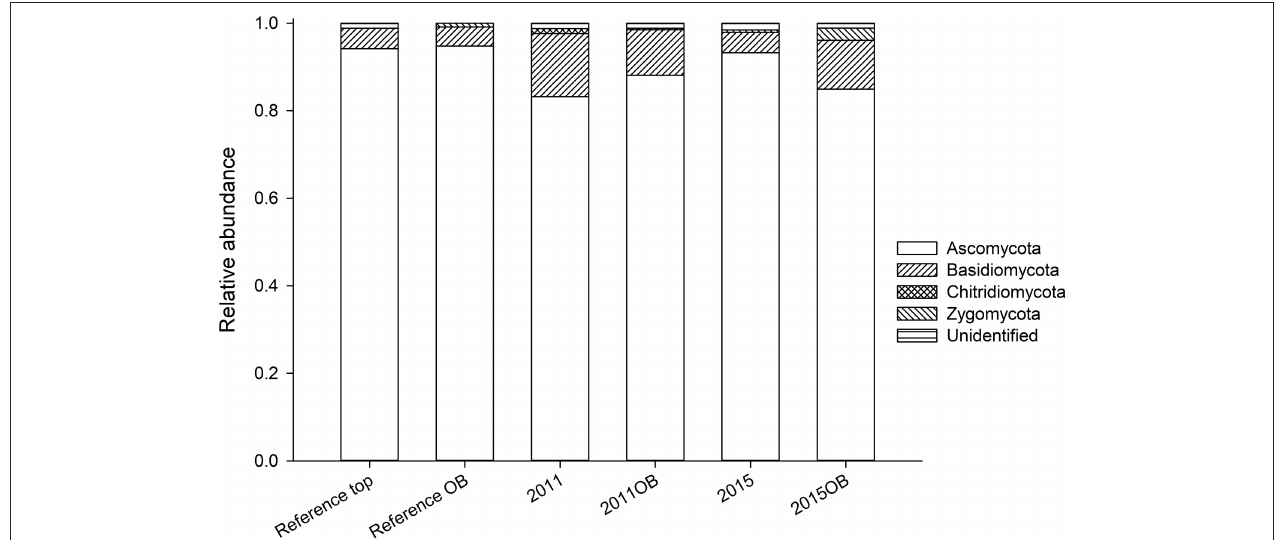
FIGURE 8 | Relative abundance of fungal phyla in samples receiving topsoil transfer compared to those receiving overburden.